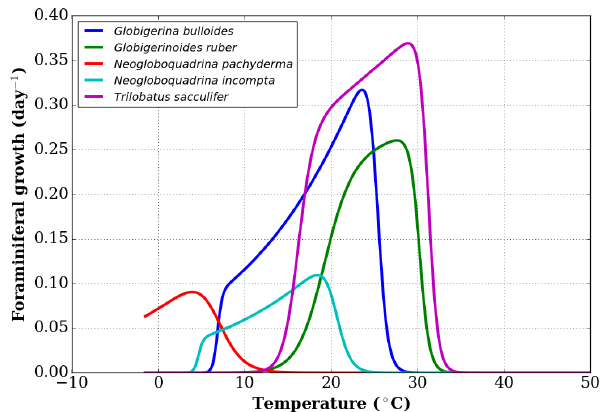
Figure 1. Growth functions corresponding to Eq. (1) over the full temperature range considered, replotted from Lombard et al.